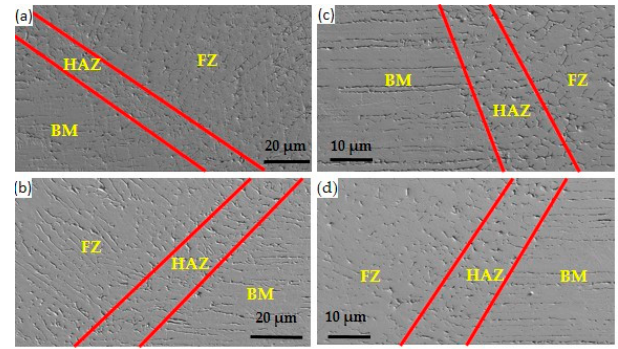
Figure 2. Microstructure of the different zones of the samples. ( a ) B4 = 7.5 T, ( b ) B3 = 5.0 T, ( c ) B1 = 0T, and ( d ) B2 = 2.5 T.